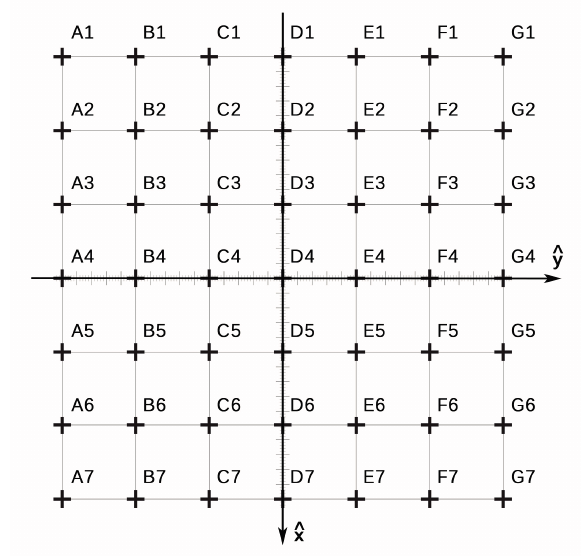
Figure 3. Measurement grid. A 6 × 6 grid with 25 cm × 25 cm squares covering an area of 1.5 m 2 was used to measure the estimated position of the right ankle